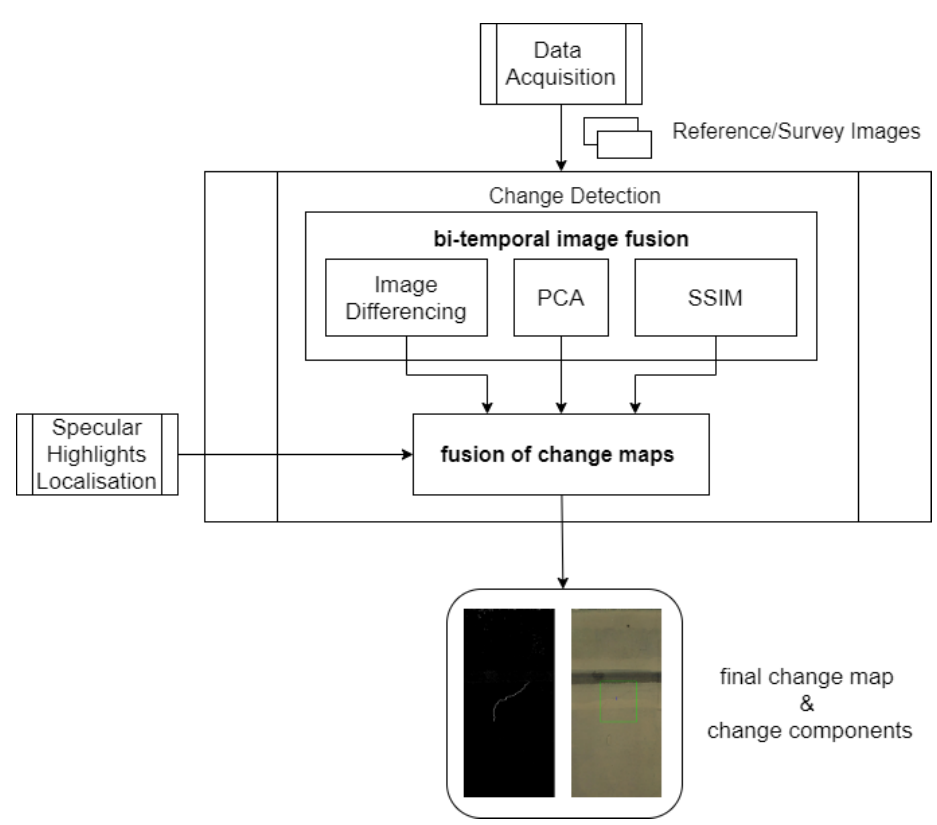
Figure 1. Block diagram of the proposed automatic inspection solution.